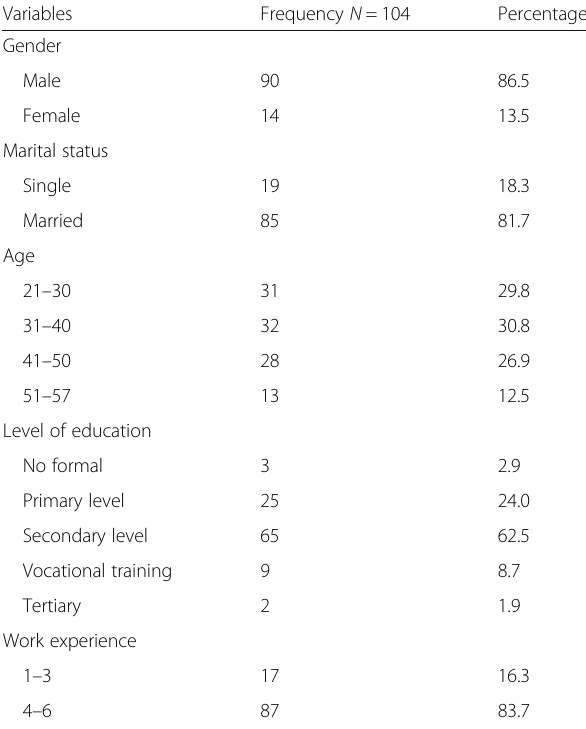
Table 1 Socio-demographic characteristics of farmers working in small-scale tomato farms, Cameroon, 2017 ( N =